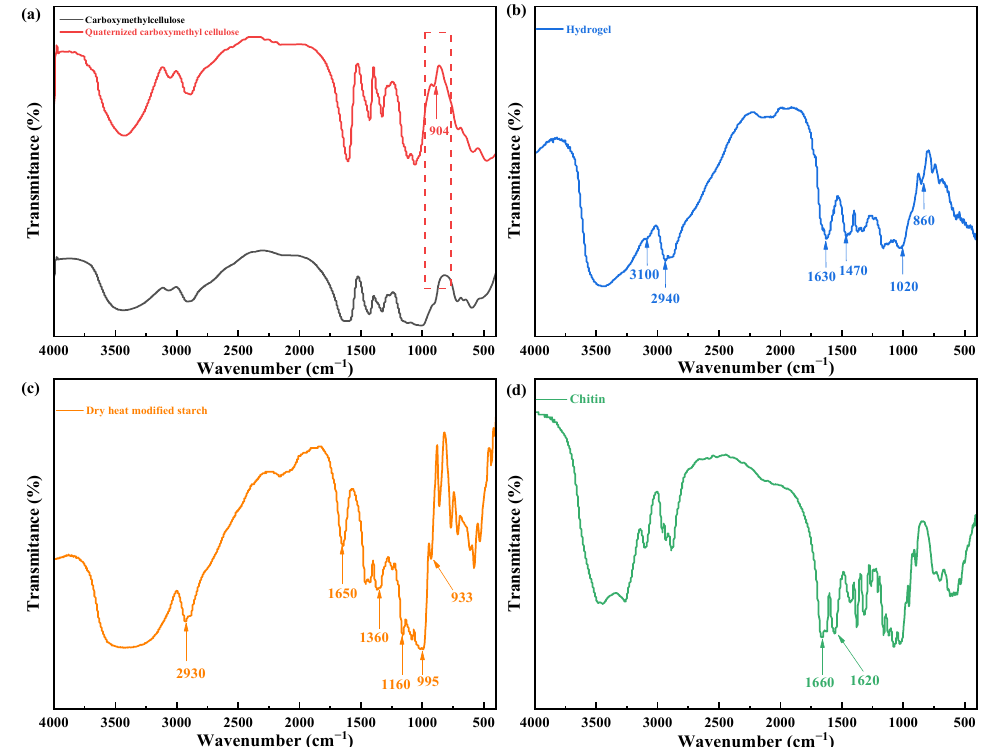
Figure 8. Fourier-transform infrared spectra of the hydrogel and raw materials. ( a ) carboxymethyl- cellulose (black line) and quaternized carboxymethylcellulose (red line), ( b ) Hydrogel, ( c ) dry heat modified starch and ( d ) Chitin.